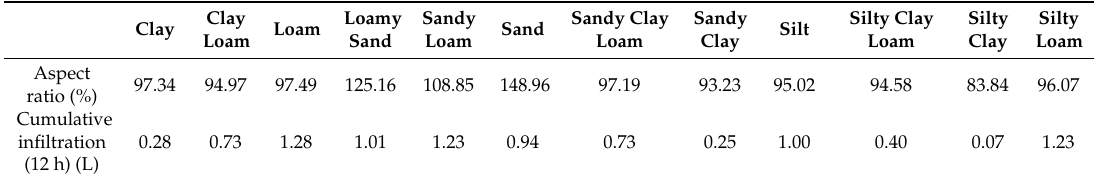
Table 4. Cumulative infiltration and aspect ratio of ceramic emitters in different